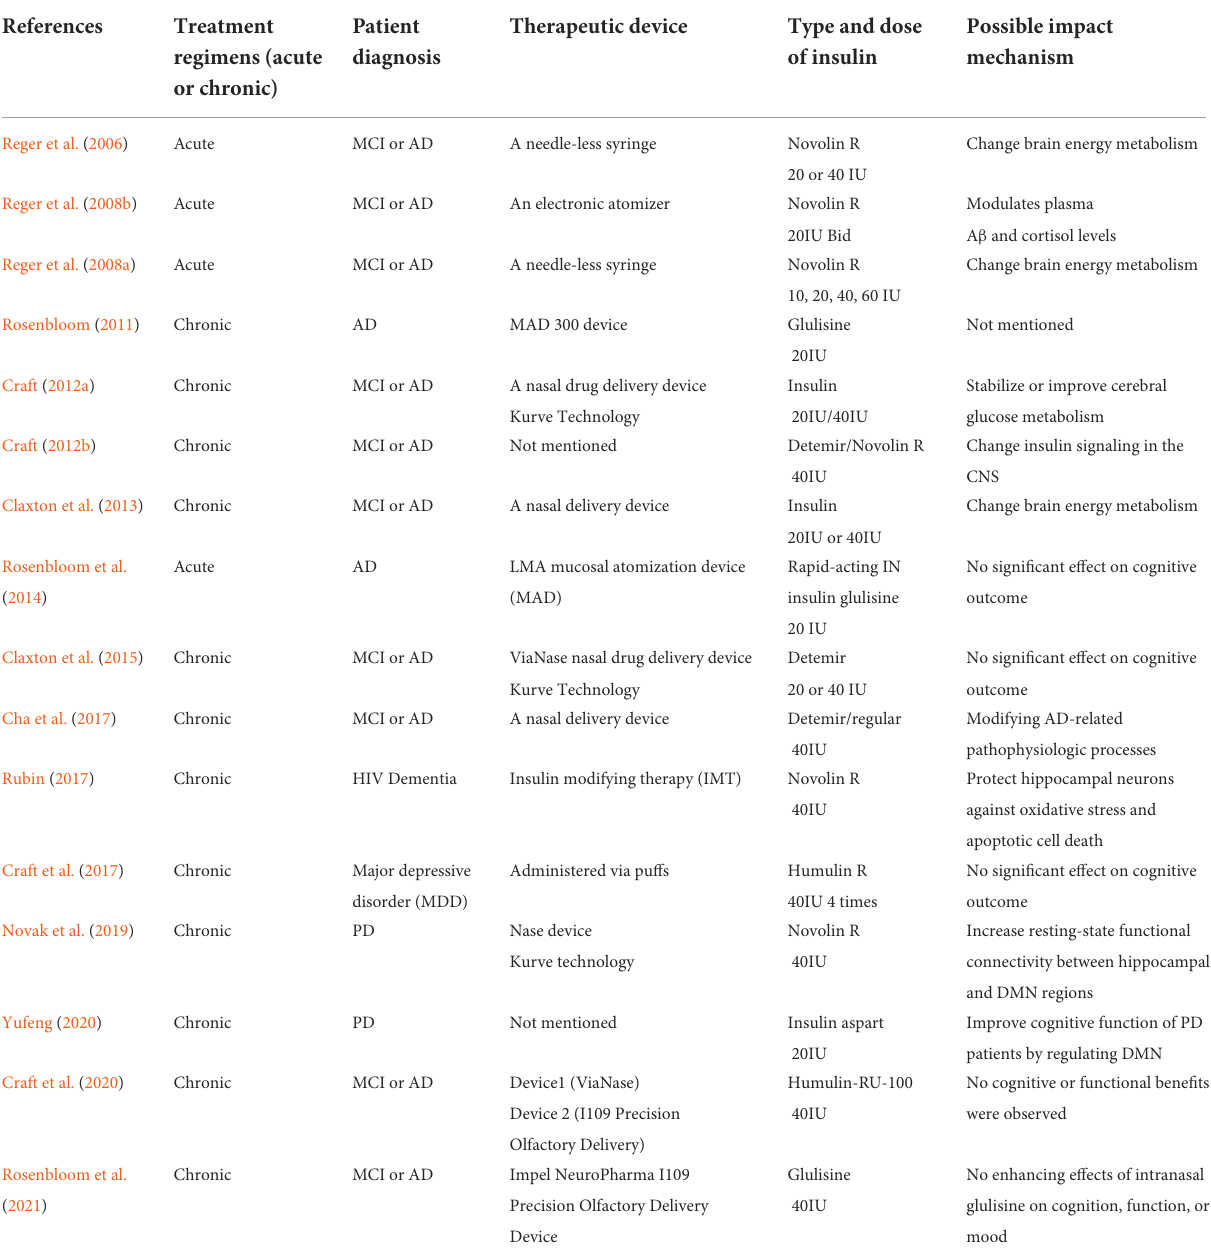
TABLE 2 Characteristics of included